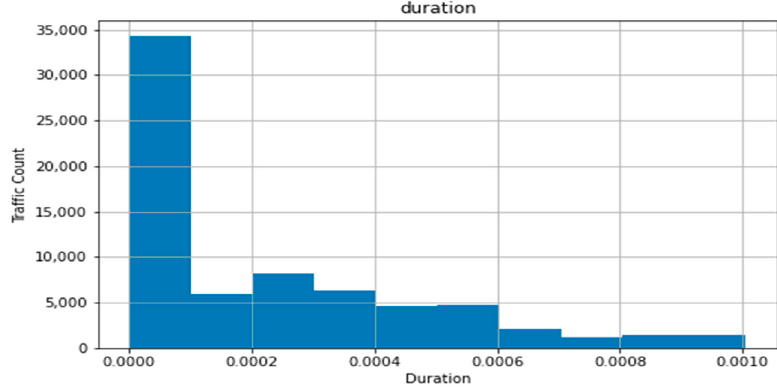
Figure 3. Normal distribution of duration with improved standard deviation.